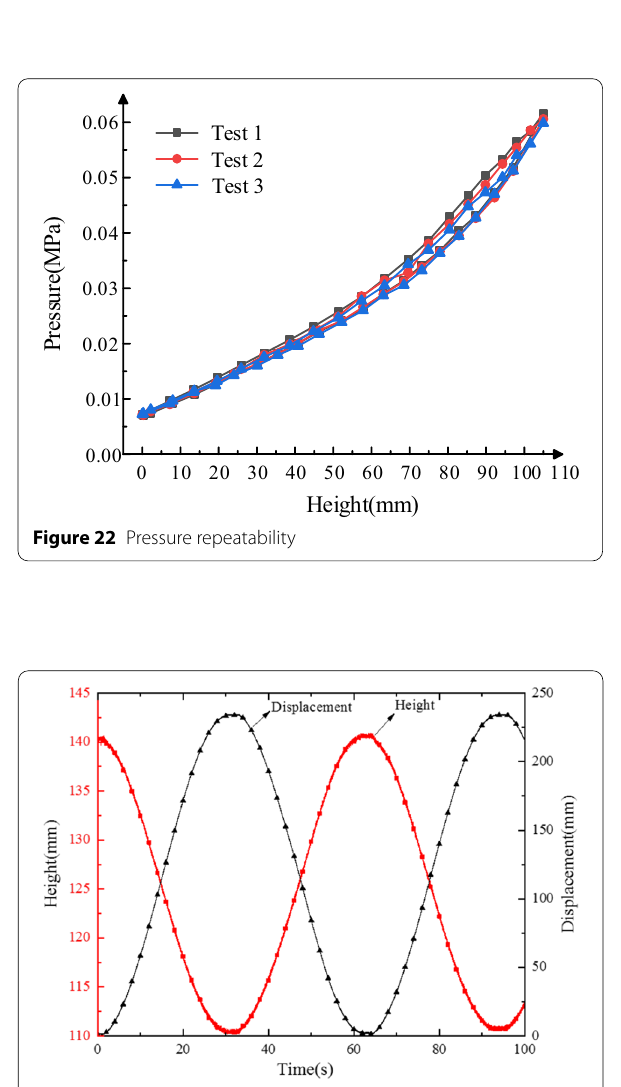
Figure 23 Change in height of the VVPR as displacement of the